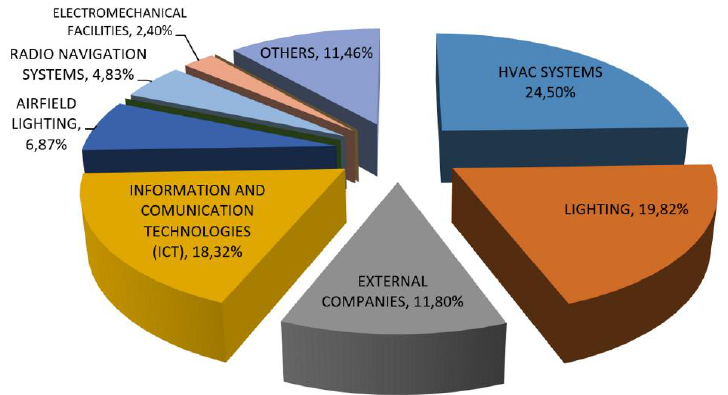
Figure 3. Energy consumption by facilities at Santander airport. Source: Airport Seve Ballesteros-Santander.